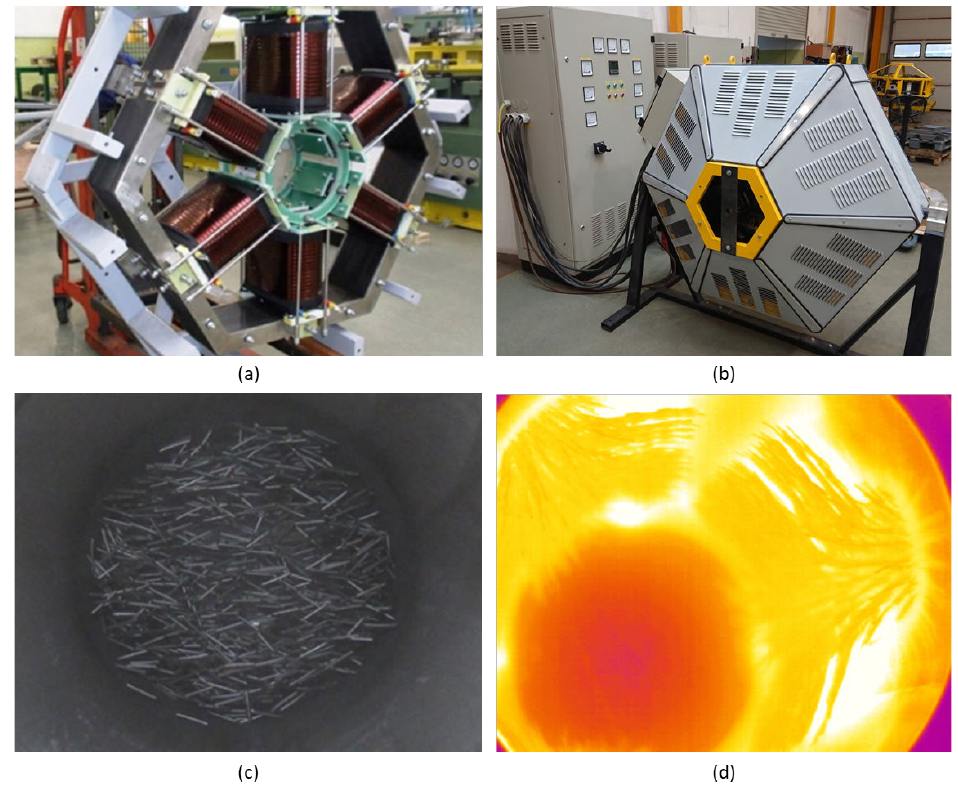
Figure 1. Electromagnetic mill D200: ( a ) inductor; ( b ) mill on the test stand without the working chamber; ( c ) ferromagnetic rods (grinding medium) moving inside the working chamber; ( d ) grinding medium during stop procedure arranging according to the pole lines (thermo-vision image).